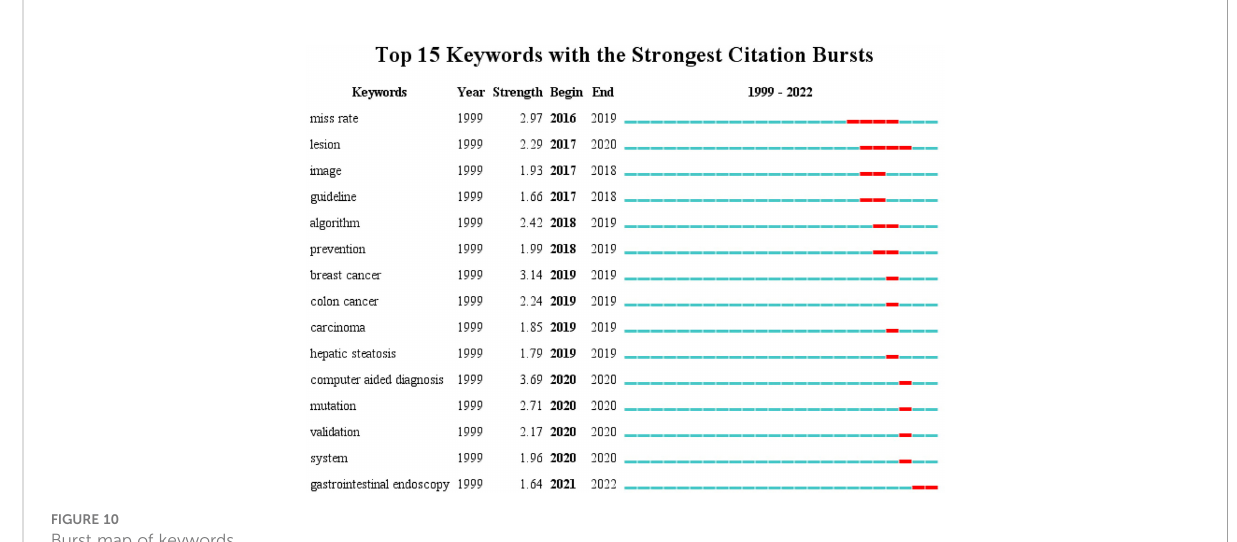
FIGURE 10 Burst map of